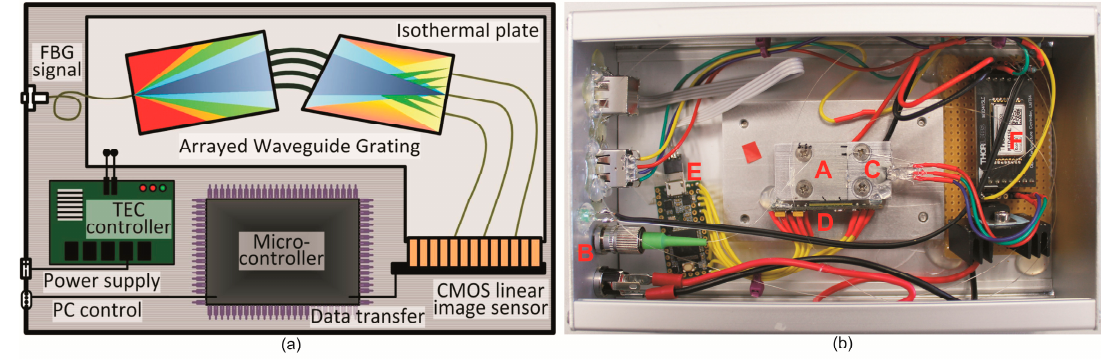
Figure 2. Schematic ( a ) and photographic ( b ) overview of the AWG interrogator. The polymeric AWG (A) is connected with a single-mode fiber (B) at the input and fixed on an isothermal plate (C). The output waveguides end facets are attached directly to the vertical CMOS linear image sensor (D). The CMOS sensor is read-out by a microcontroller (E). The TEC controller (F) is also allocated within the system.